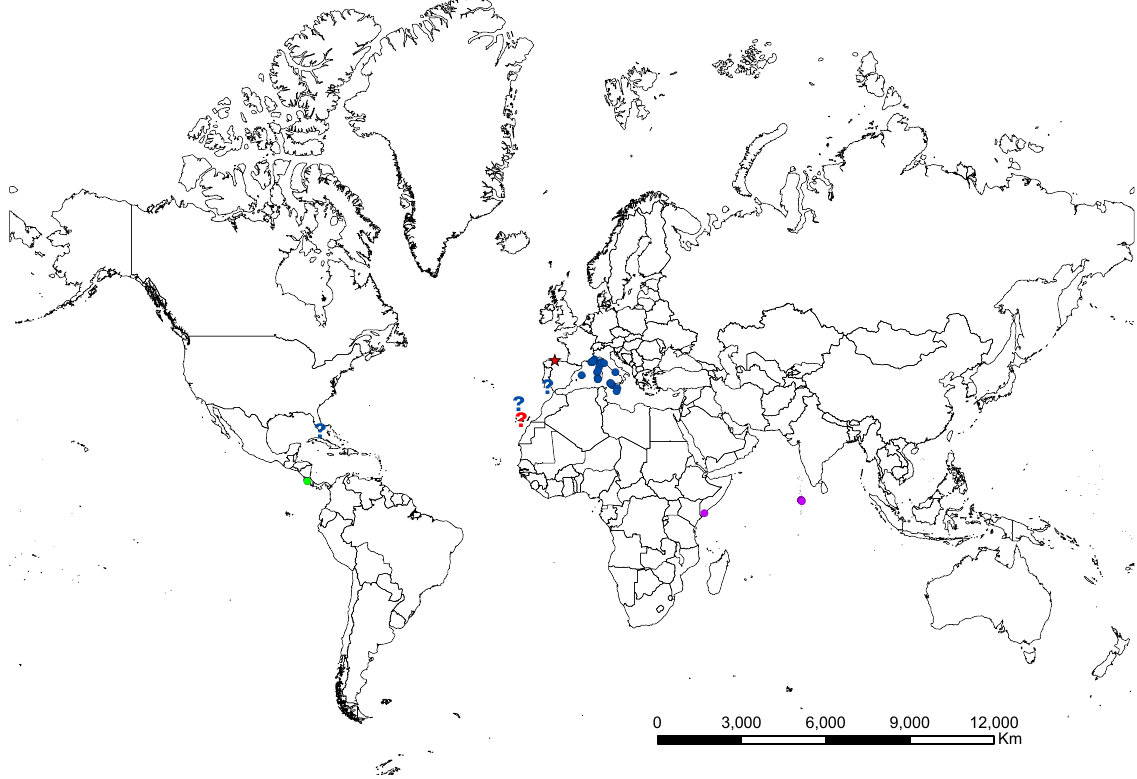
Fig. 7. Distribution of different species of Buchnerillo Verhoeff, 1942: B. litoralis Verhoeff, 1942 ( ● ), unconfirmed records of B. litoralis ( ? ), B. oceanicus Ferrara, 1974 ( ● ), B. neotropicalis Taiti, Montesanto & Vargas, 2018 ( ● ), B. atlanticus sp. nov. ( ★ ) and unconfirmed records of B. atlanticus sp. nov. ( ?